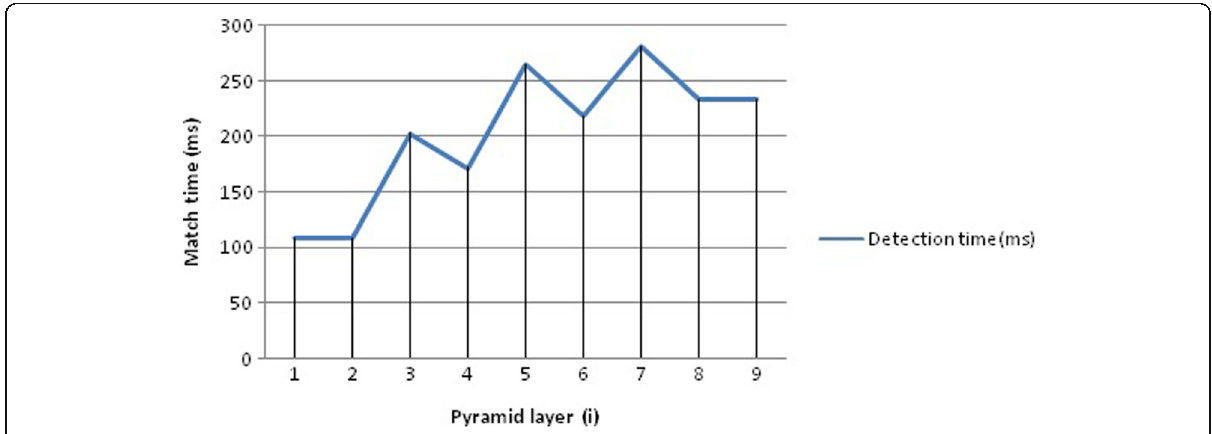
Fig. 15 Pyramid layer change and matching time relationship